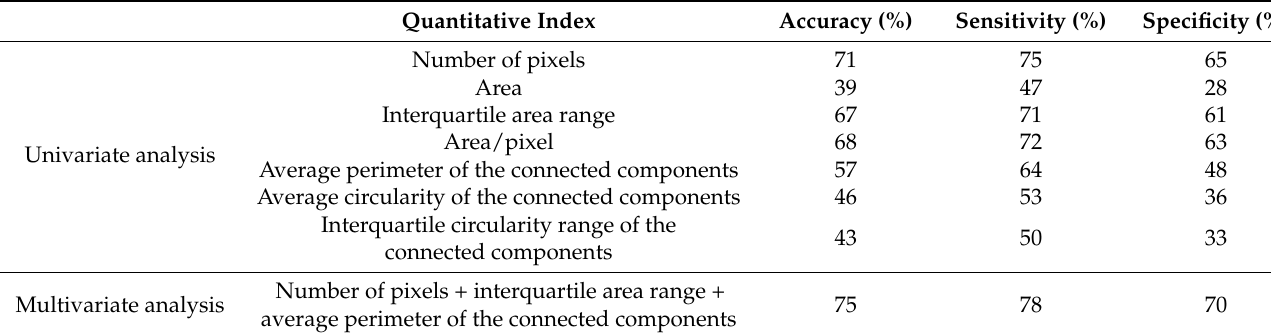
Table 1. Univariate and multivariate analysis